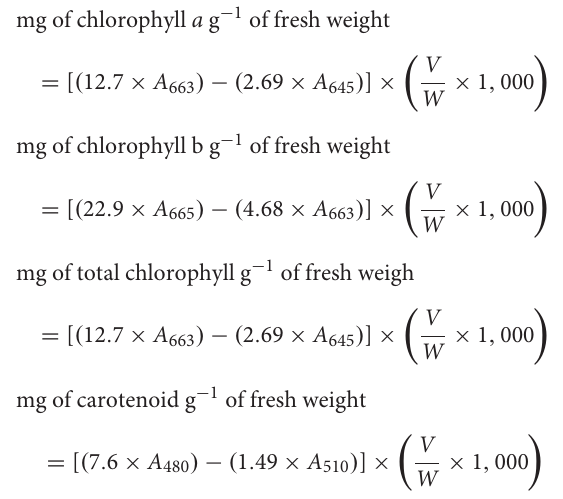
blank containing 80% acetone. The amount of chlorophyll a